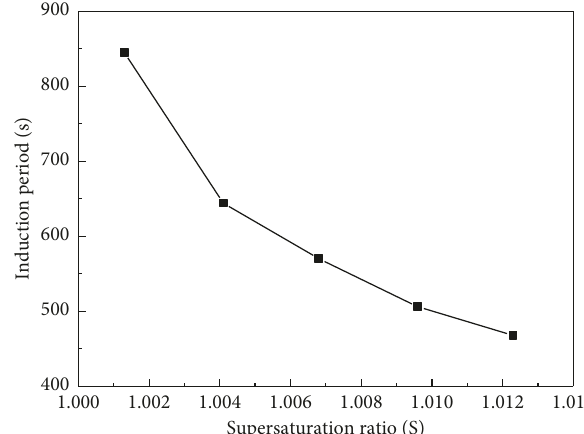
Figure 6: Induction period versus supersaturation ratio of sodium chloride.